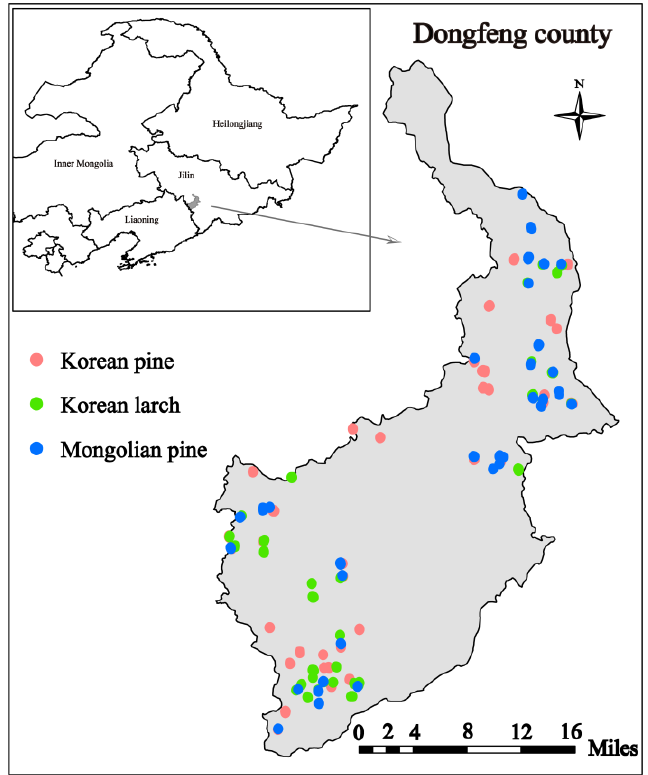
Figure 1. The map study area and the distribution of the spatial plots.